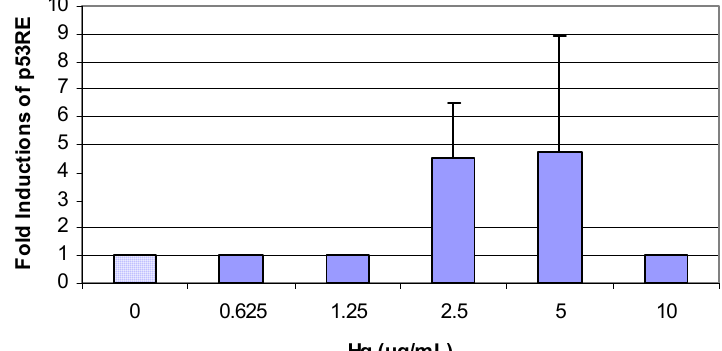
Figure 8. Fold induction of p53RE in HepG means ± SDs, n = 3.